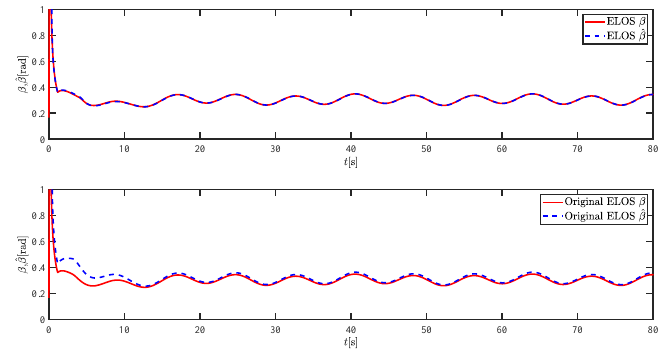
Figure 11. Along-track error x e and cross-track error y e at fast speed.